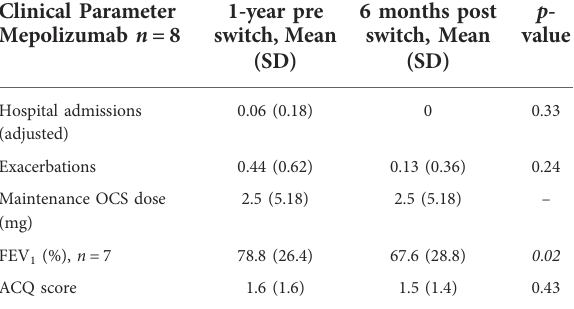
TABLE 3 Comparing the mean values of the fi ve clinical parameters measured in this study 1 year before switching from reslizumab to mepolizumab to the mean values of the same parameters 6 months after